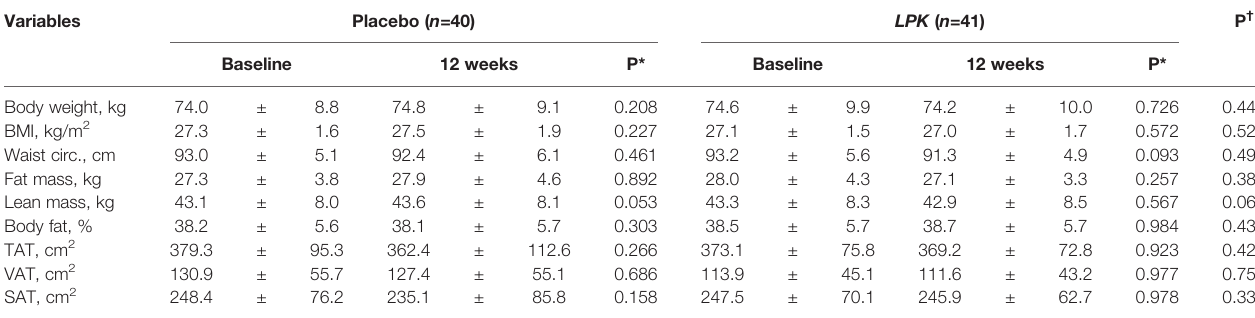
TABLE 2 | Changes in body composition in the LPK and placebo groups after 12 weeks. Variables